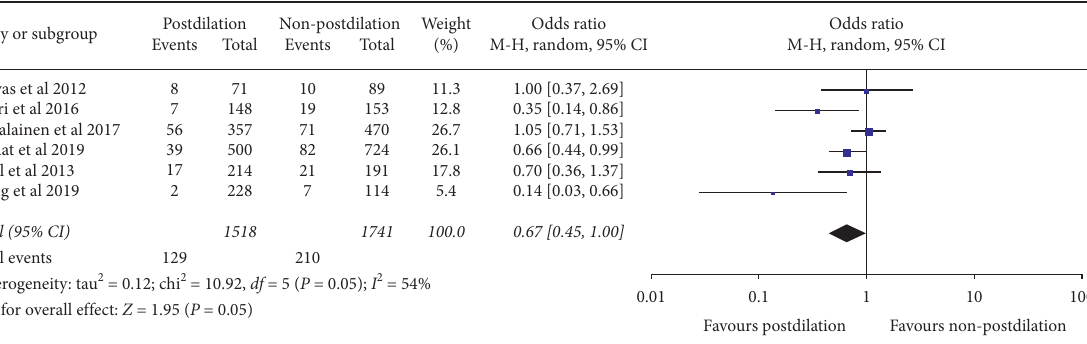
Figure 2: Forest plot of primary clinical outcome between postdilation and non-postdilation group. Notes: MACE � major adverse cardiac events.